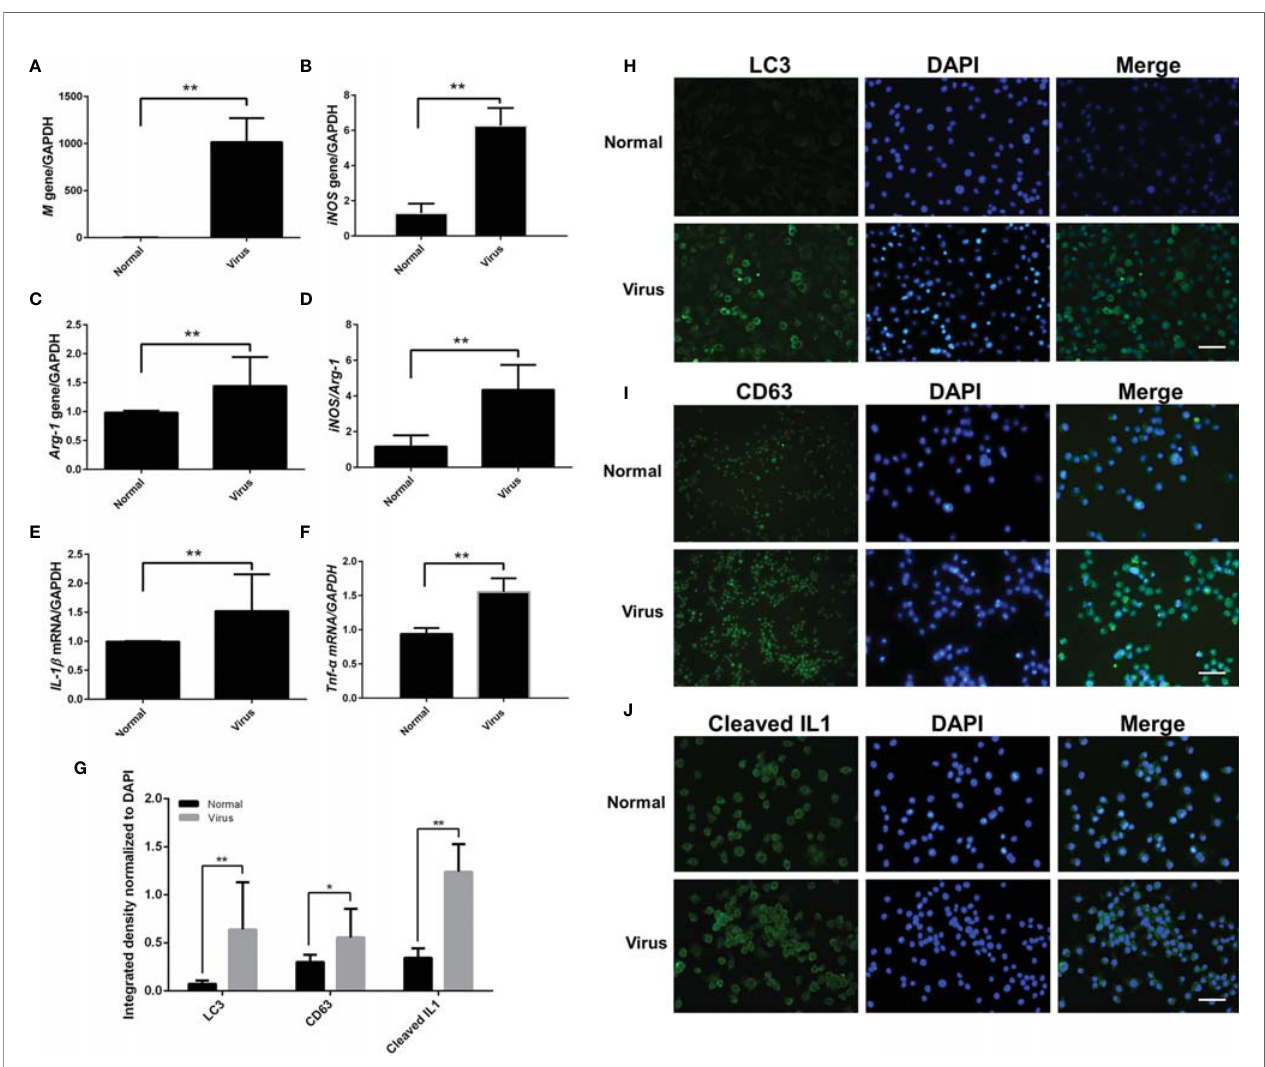
FIGURE 3 | M1 polarization and LC3/CD63/IL-1 b analysis of infected ANA-1 macrophages. Total RNA was isolated from infected ANA-1 cells at 24-h post-infection and used for transcriptional analysis of the related genes. (A) In fl uenza virus M gene. (B) iNOS gene (M1 marker). (C) Arg-1 gene (M2 marker). (D) iNOS/Arg-1 (M1/M2 bias). (E) IL-1 b (a proin fl ammatory cytokine). (F) Tnf- a (an in fl ammatory cytokine). N ≥ 3, ** p < 0.01. (G – J) Normal and infected ANA-1 cells were fi xed, incubated with primary antibodies (LC3/CD63/cleaved IL-1 b , 1:1000 dilution), and then fl uorescently stained with the secondary antibody (anti-rabbit IgG F ab 2 Alexa Fluor ® 488 molecular probes, 1:2000 dilution). (G) The cells ’ fl uorescence intensity of LC3, CD63, and cleaved IL1-1 b was quanti fi ed and normalized by the corresponding DAPI fl uorescence amount using the Image-Pro Plus 6.0 software. No fewer than three fl uorescent images were captured and analyzed for each group. * p < 0.05 and ** p < 0.01. (H) LC3 cellular immuno fl uorescence. (I) CD63 cellular immuno fl uorescence. (J) Cleaved IL-1 b cellular immuno fl uorescence. Scale bar: 50 m